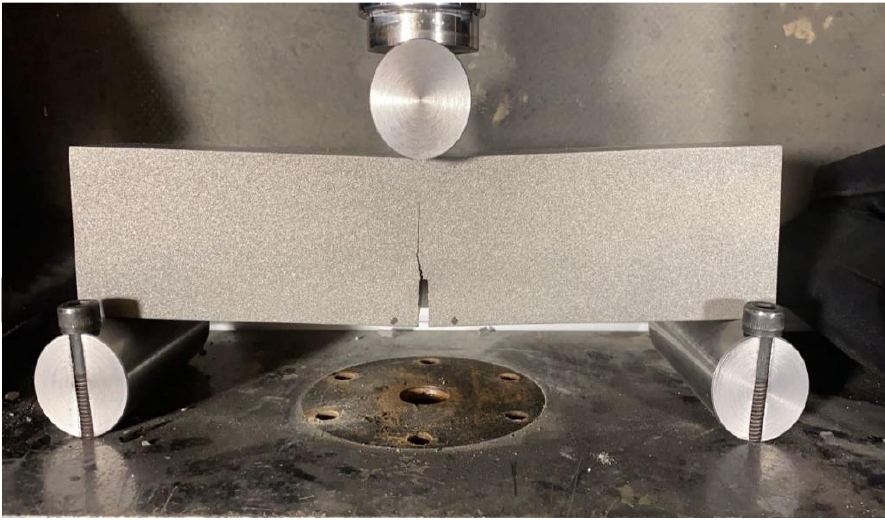
Figure 3. The geometry of three-point bending conditions for a sample of Fe-based amorphous coat-